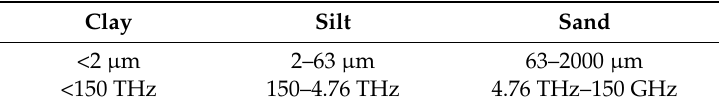
Table 1. Soil particle size fractions and corresponding THz frequencies.